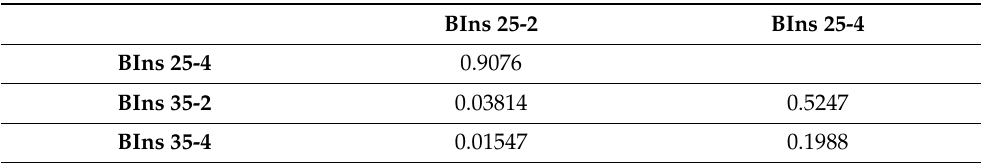
Table 2. Effect of the diameter of the instrument on the canal cleanness score observed af- ter biomechanical instrumentation (Mann-Whitney pairwise test, Bonferroni corrected p values). BIns = Biomechanical instrumentation (#-mm from